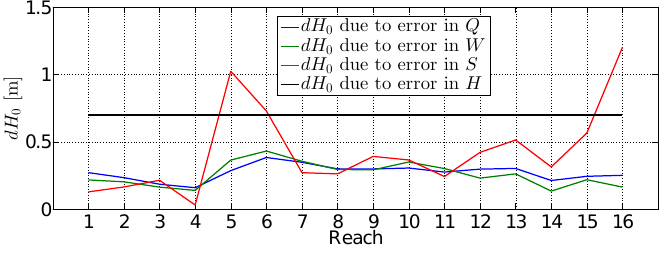
Figure 12. Average error in H 0 due to errors in discharge, water level, effective river width and slope over all 16